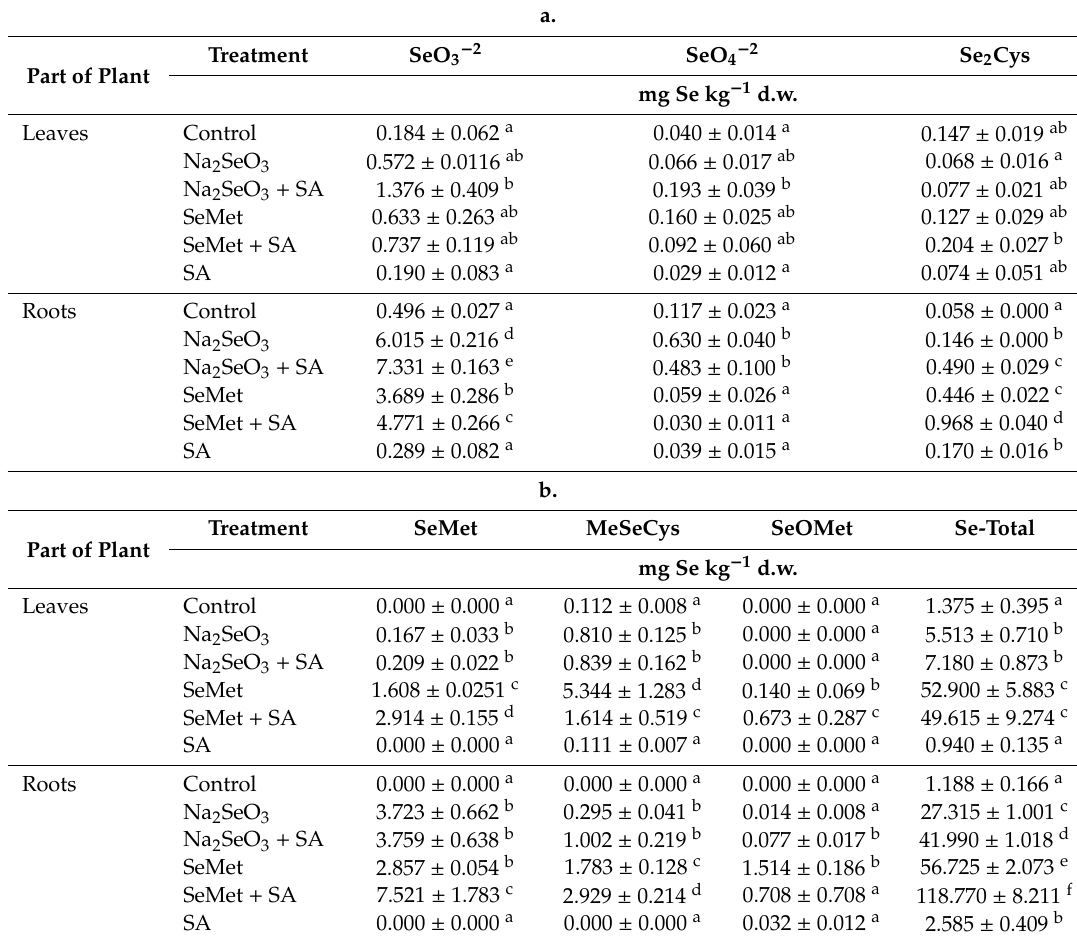
Table 5. The content of Se speciation forms and total Se in lettuce leaves and